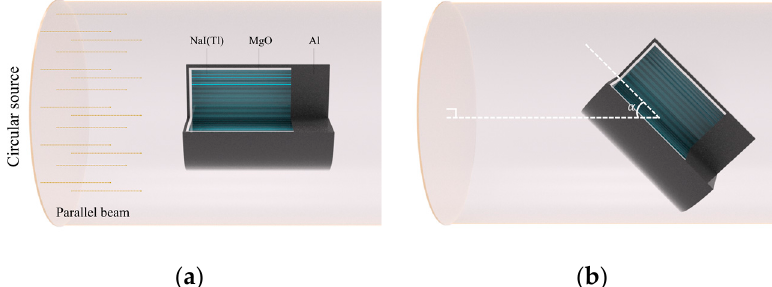
Figure 2. Schematic of the calculation geometry defined for MCNP6 simulations. ( a ) A parallel photon beam was irradiated on an NaI(Tl) detector. ( b ) The directions of the detector were rotated against the circular source by specific angle α . A 20 mm-thick aluminum disk was positioned on the back of the crystal to consider the scattering in a photomultiplier tube.